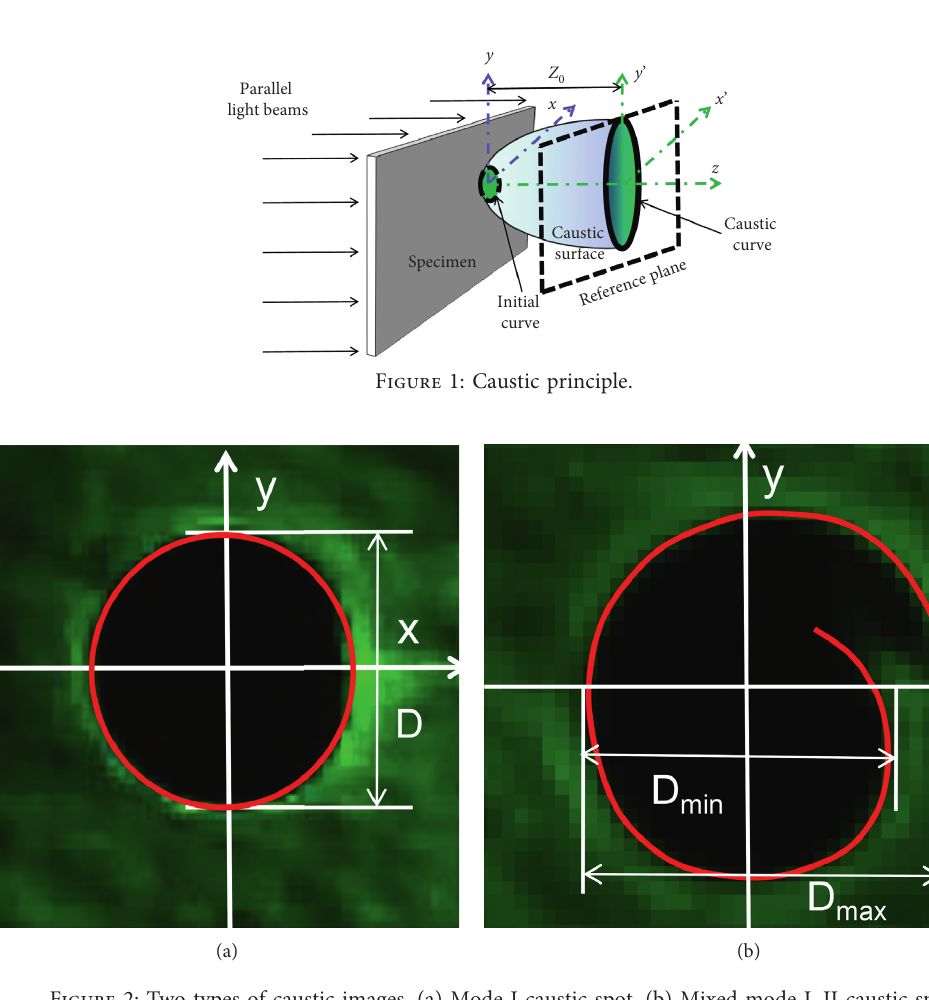
Figure 2: Two types of caustic images. (a) Mode I caustic spot. (b) Mixed mode I–II caustic spot.